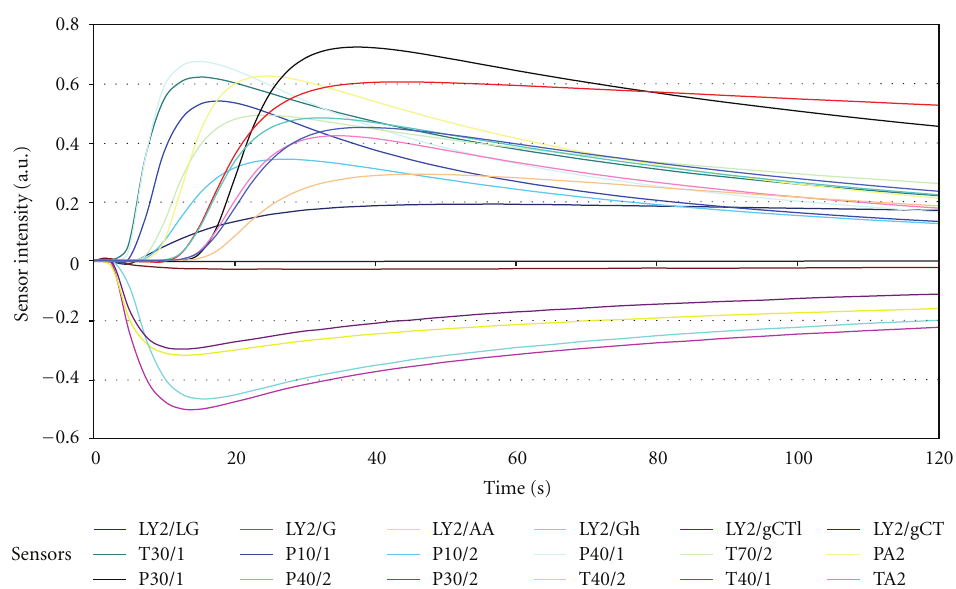
Figure 1: Signals of the 18 semiconductor oxide metallic sensors pure and doped